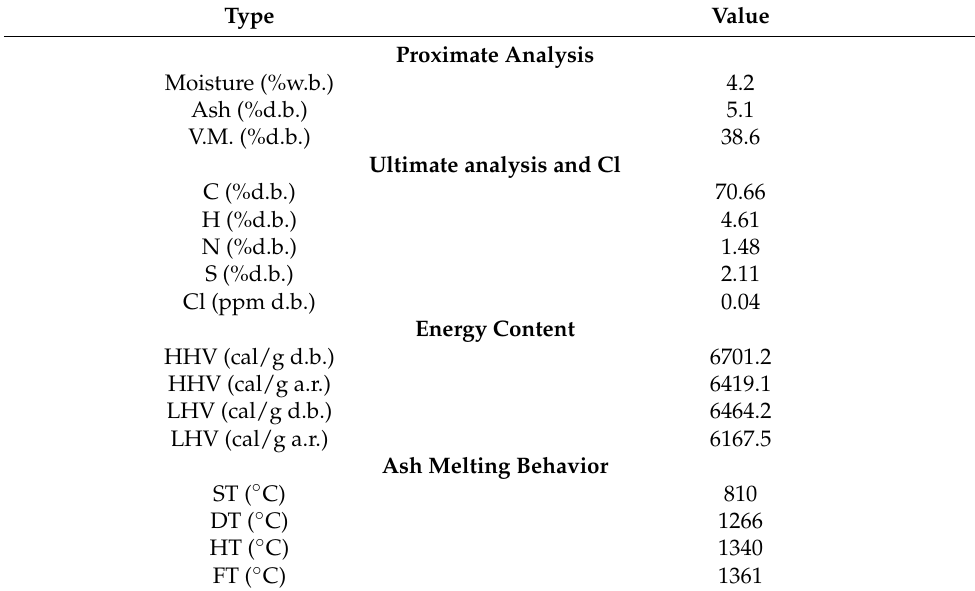
Table 12. Mixed fuel